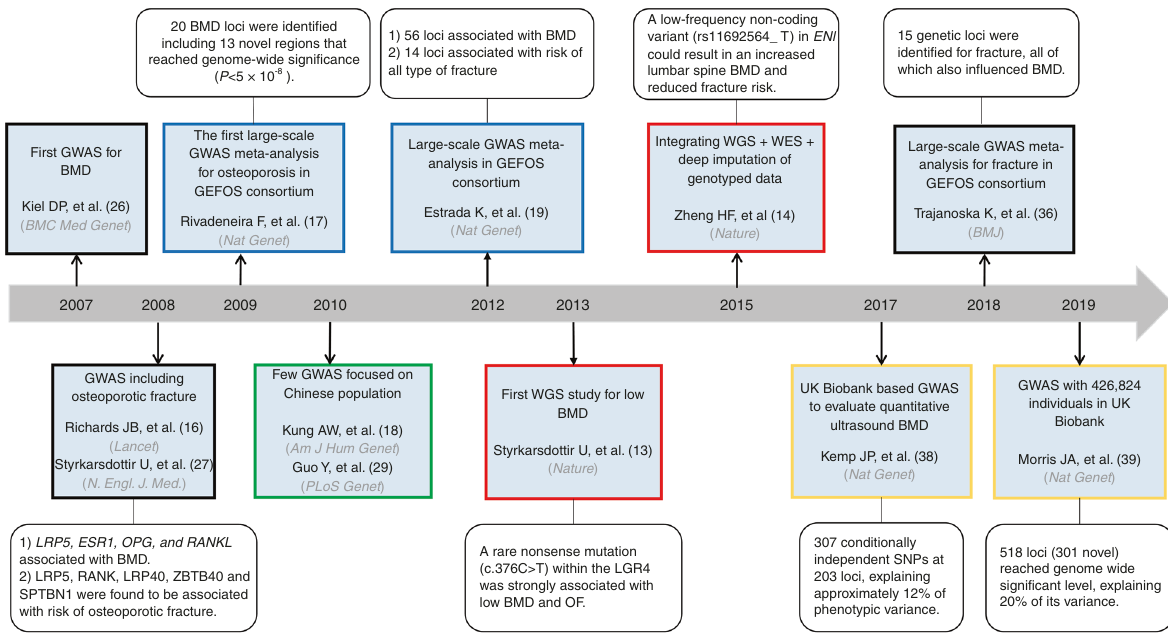
Fig. 1 Timeline highlighting important milestones during the 12 years of GWAS discoveries for osteoporosis and related traits. Blue boxes indicate the studies from the GEFOS and GENOMOS consortia. The green box indicates the studies focused on the Chinese population. Red boxes indicate GWASs including rare variants. Yellow boxes indicate the UK Biobank-based GWAS. BMD bone mineral density, ESR1 estrogen receptor 1, GWAS genome-wide association study, LRP5 low-density lipoprotein receptor-related protein 5, LRP40 low-density lipoprotein receptor-related protein 4, OPG osteoprotegerin, RANK receptor activator of nuclear factor-kappa β , RANKL RANK ligand, SPTBN1 spectrin beta, nonerythrocytic 1, WES, whole-exome sequencing, WGS whole-genome sequencing, ZBTB40 zinc fi nger and BTB domain containing Bone mass can also be assessed with other radiological imaging tools, such as quantitative computed tomography (QCT), which has the advantage of revealing unique bone information. Paternoster et al. 22 performed the fi rst GWAS on cortical vBMD measured by QCT and found that the genetic variant rs1021188 near the RANKL gene was associated with the density of cortical bone, and rs9287237 on FMN2 was associated with the trabecular bone fraction, while the other three SNPs (rs271170 on LINC00326 near EYA4 , rs7839059 on COLEC10 near OPG and rs6909279 on CCDC170 near ESR1 ) had previously been reported to be associated with aBMD. However, QCT was not applicable to the WHO de fi nition of osteoporosis that was based on DXA measurement, and QCT was more expensive with a higher dosage of exposure to radiation but might not predict fractures better than DXA measurement. 23